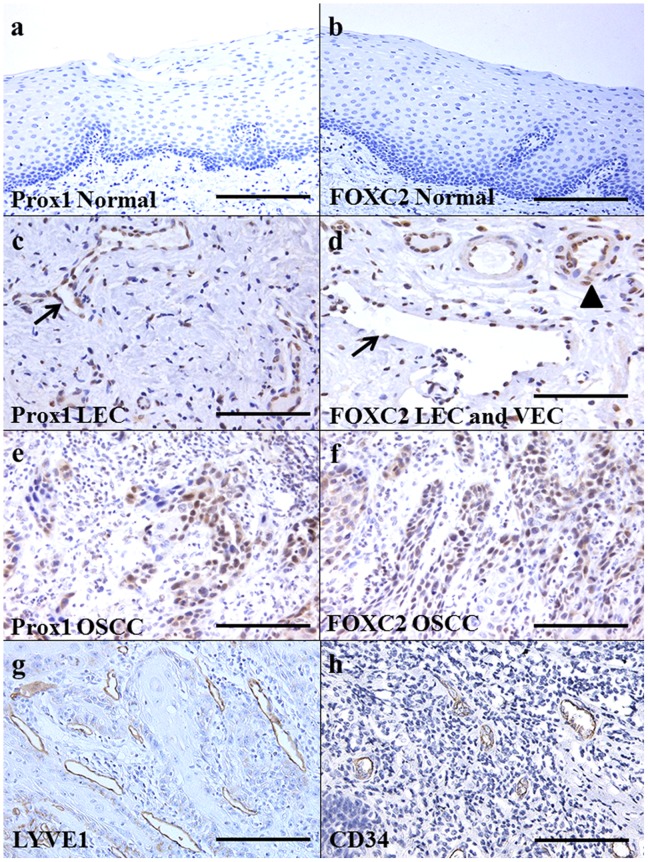
Immunohistochemical analysis of Prox1 and FOXC2 in human OSCC cases.Prox1 (a) and FOXC2 (b) expression were not observed in non-tumor oral mucosa. The lymphoendothelial cells (arrow) showed immunoreactivity to Prox1 (c) and expression of FOXC2 was found in lymphoendothelial cells (arrow) and vascular endothelial cells (arrow head) (d). Expression of Prox1 (e) and FOXC2 (f) were observed in cytoplasm of the cancer cells. LYVE1 positive lymphovessels (g) and CD34 positive blood vessels were counted for MVD and LVD, respectively. Original magnification was 200-fold. Bar, 100 μm. LEC; lymphoendothelial cells, VEC; vascular endothelial cells.